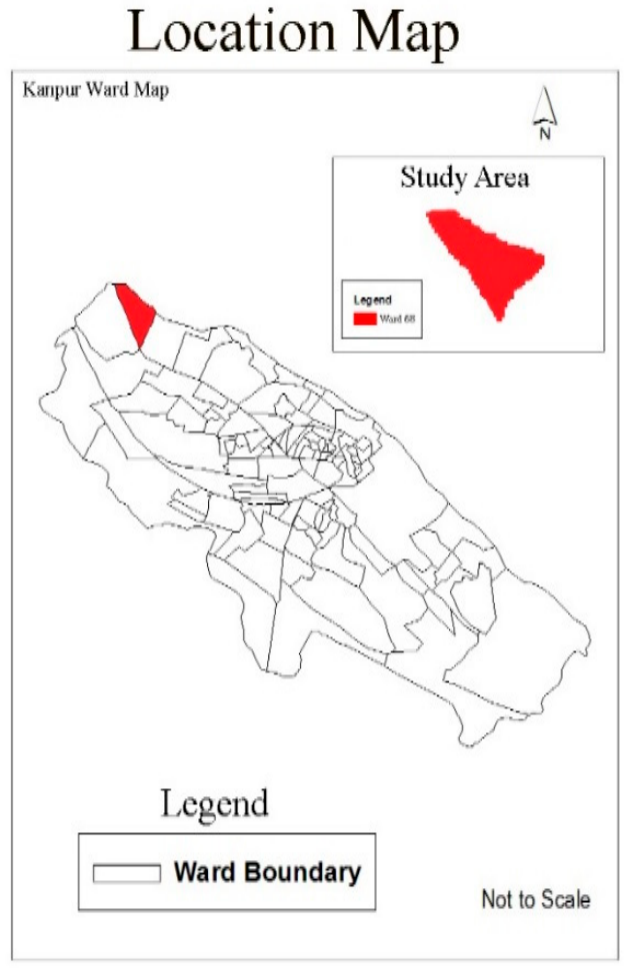
Figure 1. Location map for the study